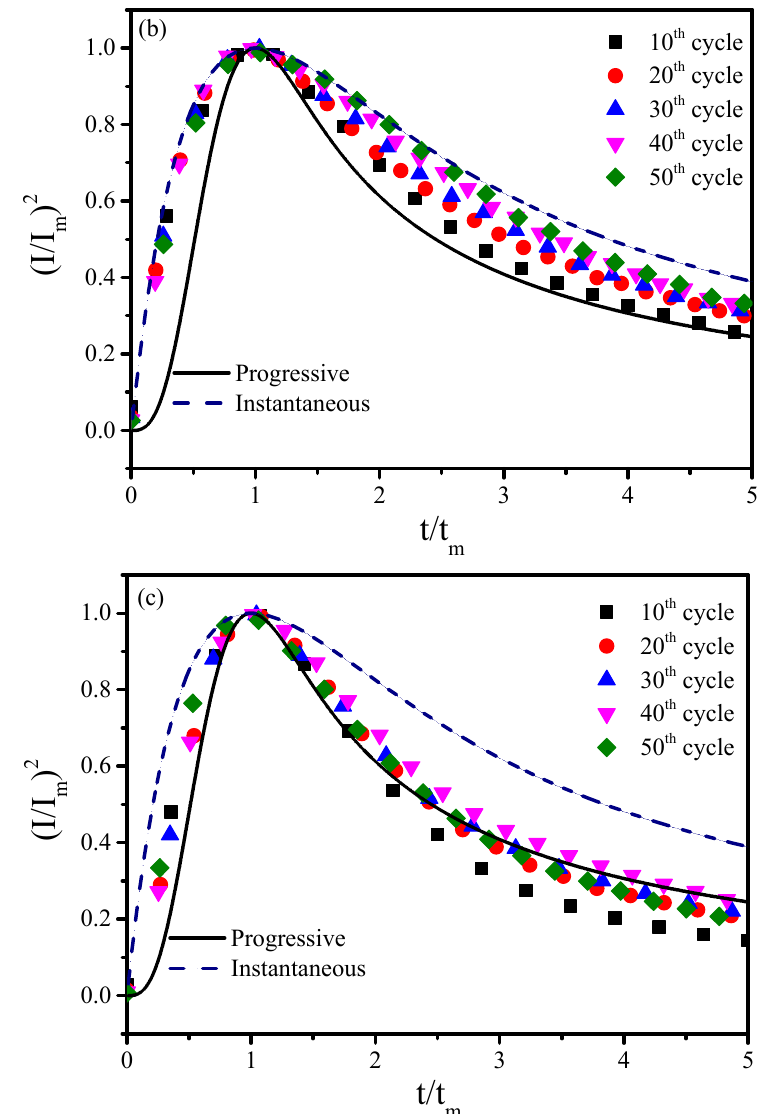
Figure 4. ( I / I m ) 2 vs. t / t m curves for the UPD-Mn in the electrolytes, with various terminated open circuit potential (OCP) times of ( a ) 60 s, ( b ) 40 s, and ( c ) 20 s.